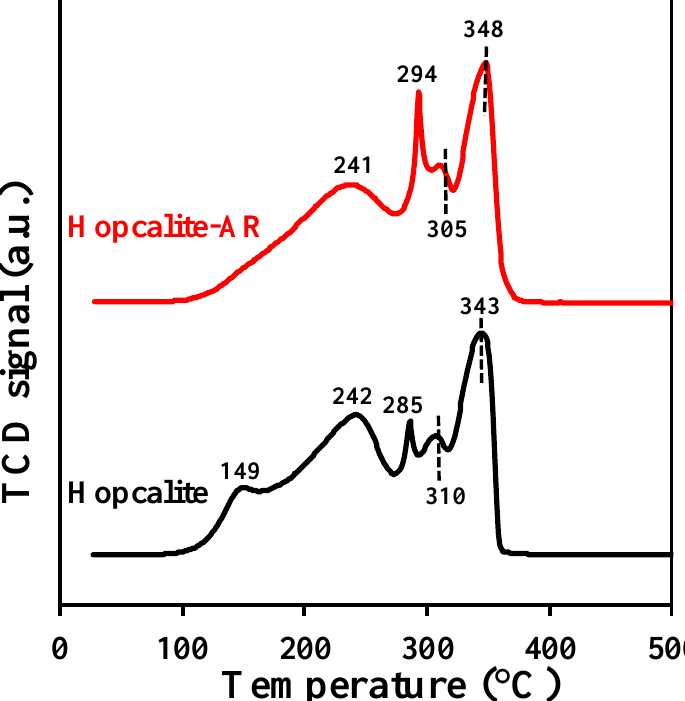
Figure 8. H 2 -TPR profiles of Hopcalite before and after reaction (Hopcalite-AR).